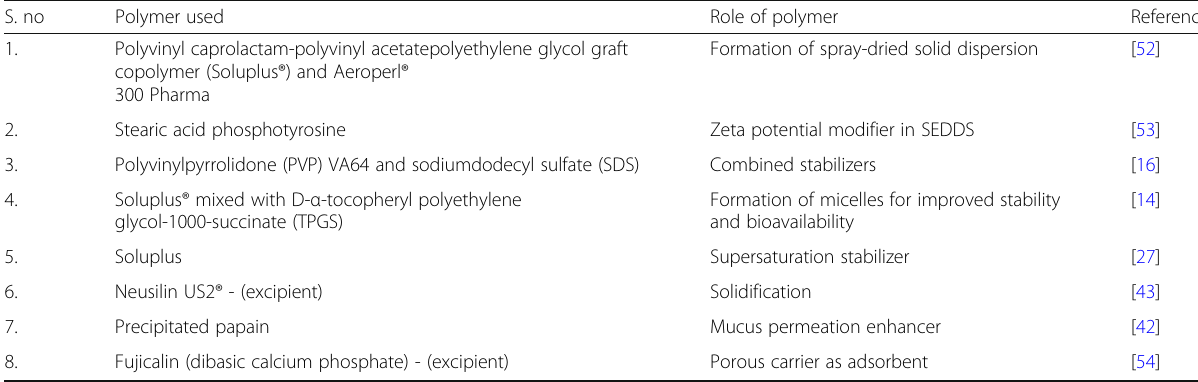
Table 2 Role of